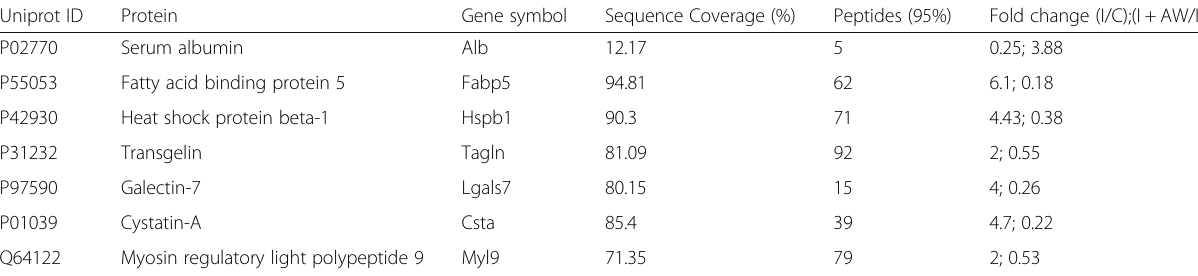
Table 2 List of the statistically significant (fold change> 2, P < 0.05) gastric tissue proteome changes in C, I and I + AW obtained from 2-DE gels after identification by LC-MS/MS analysis Uniprot ID